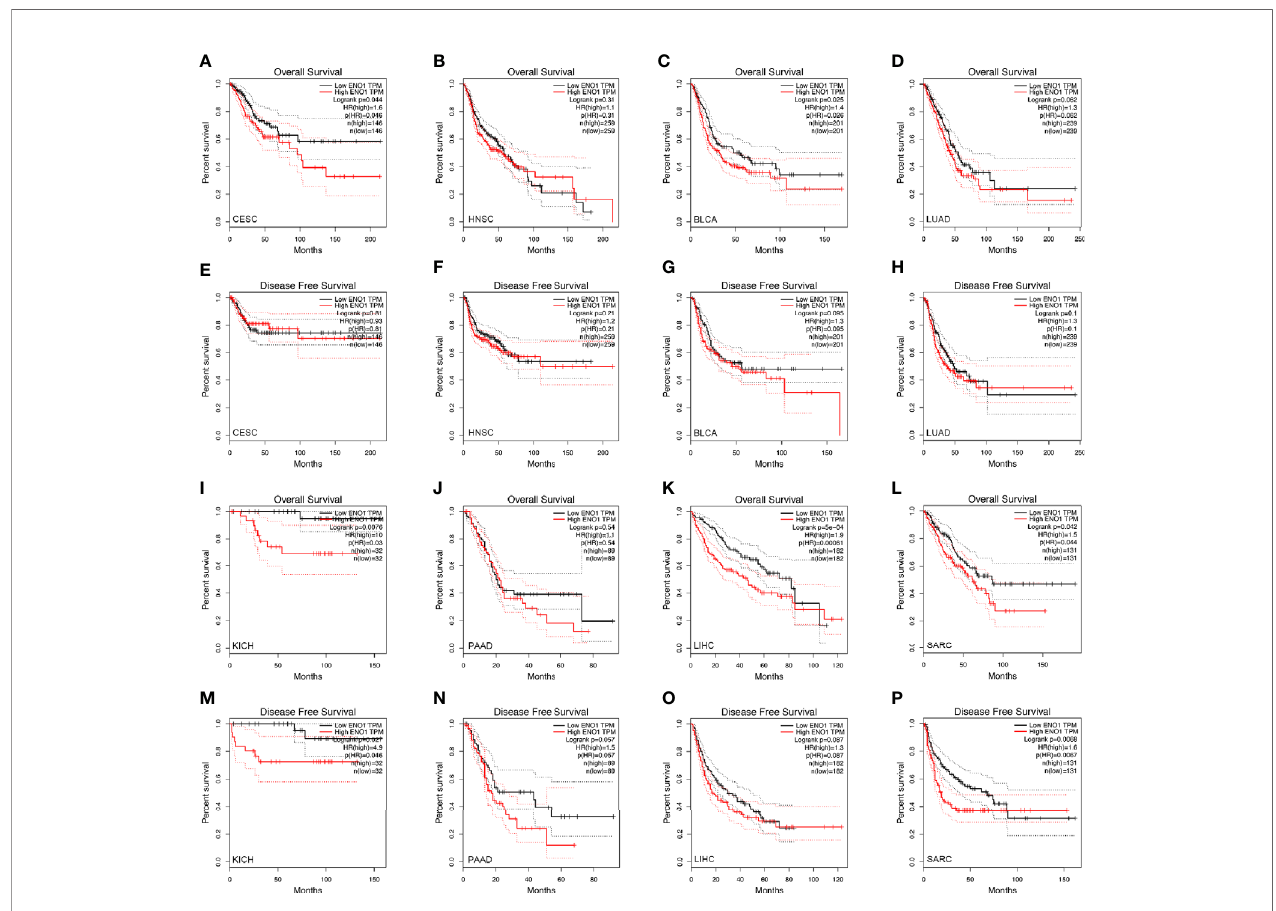
FIGURE 4 | Kaplan – Meier survival curves of the prognostic signi fi cance of high- and low-expression of ENO1 in different types of cancers using the GEPIA. Survival curves comparing survival outcomes of patients with high and low expressions of ENO1 in CESC (A, E) , HNSC (B, F) , BLCA (C, G) , LUAD (D, H) , KICH (I, M) , PAAD (J, N) , LIHC (K, O) and SARC (L, P) with 95% con fi dence interval. The 1 st and 3 rd panels show the survival curves for OS, and the 2 nd and 4 th panels show the survival curves for DFS. ENO1, enolase 1; TPM, transcripts per million; HR, hazard ratio; CESC, cervical squamous cell carcinoma and endocervical adenocarcinoma; HNSC, head and neck squamous cell carcinoma; BLCA, bladder urothelial carcinoma; LUAD, lung adenocarcinoma; KICH, kidney chromophobe; PAAD, pancreatic adenocarcinoma; LIHC, liver hepatocellular carcinoma; SARC,